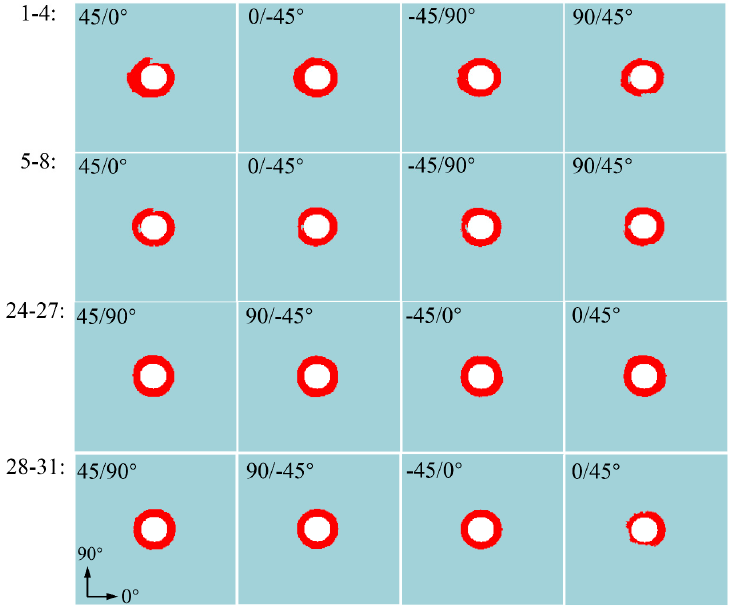
Figure 15. Cohesive element damage state of thin − ply − laminated at point B.